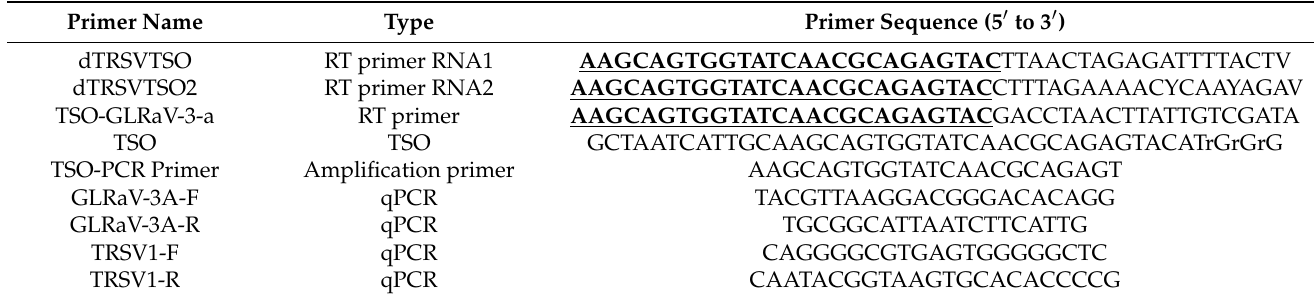
Table 1. Primer sequence sets used for ds-cDNA synthesis (RT-specific primers, template switching oligo (TSO) and amplification primer) and qPCR specific